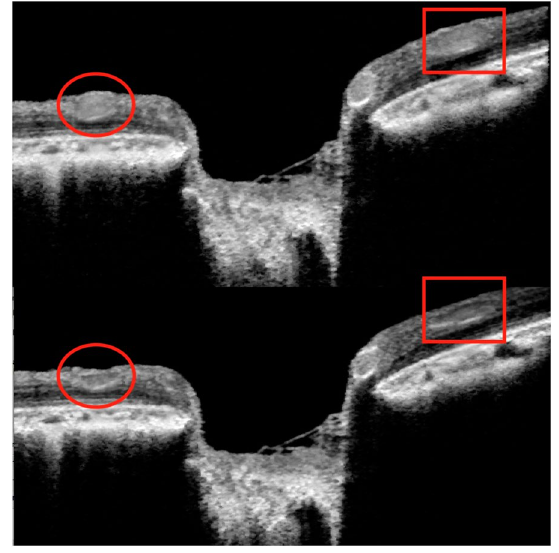
Figure 2. Visualization of the retinal spontaneous venous pulsation. Following manometrically controlled gradual increments in IOP from 5 to 50 mmHg, a subtle variation of the retinal vessel caliber was noticeable at both the confocal scanning laser ophthalmoscope live fundus image and the live vertical central B-scan of the ONH. The frame acquisition rate was approximately 13 Hz. Video recording of the live B-scan showing appearance and cessation of the pulsation induced by a rapid increase in IOP is provided in the supplement